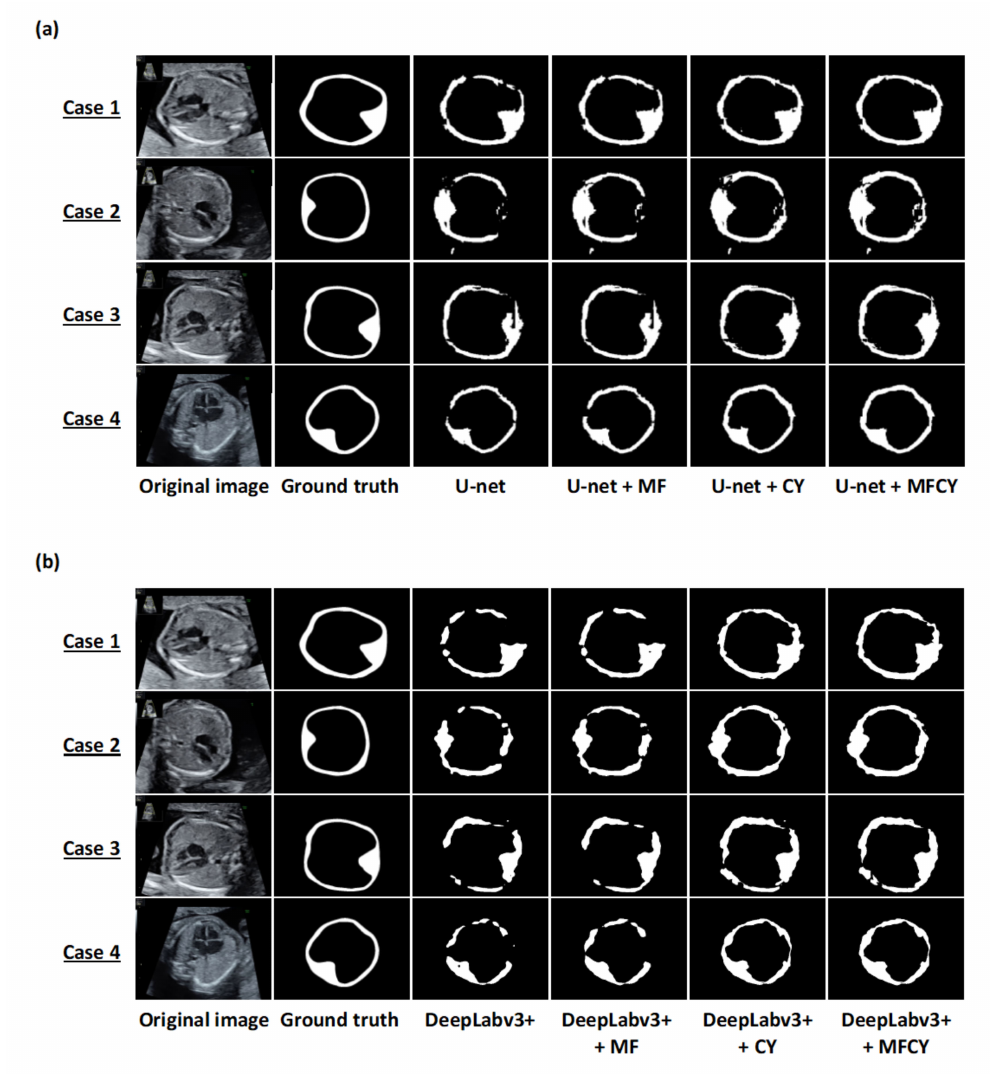
Figure 2. Representative examples of the thoracic wall segmentation by the existing models and our three methods on test datasets. Each row shows a particular case. The columns correspond to the original images, ground truths, and predictions by U-net, DeepLabv3 + , MF, CY, and MFCY. The white areas represent the labels of the thoracic wall; ( a ) corresponds to U-net and ( b ) corresponds to DeepLabv3 +